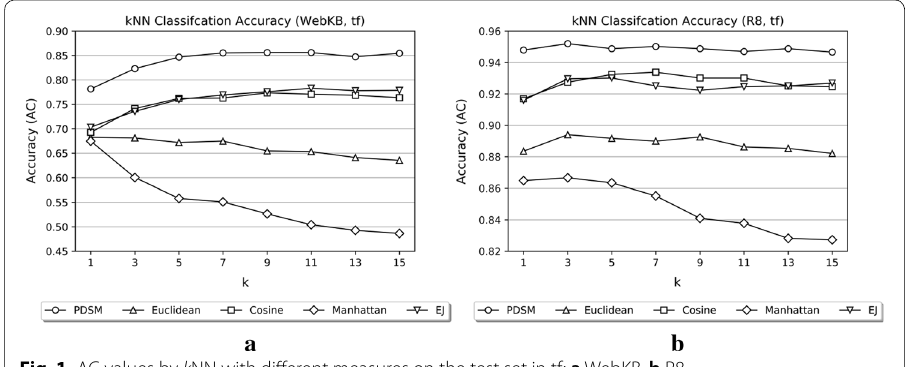
Fig. 1 AC values by k NN with different measures on the test set in tf: a WebKB. b R8